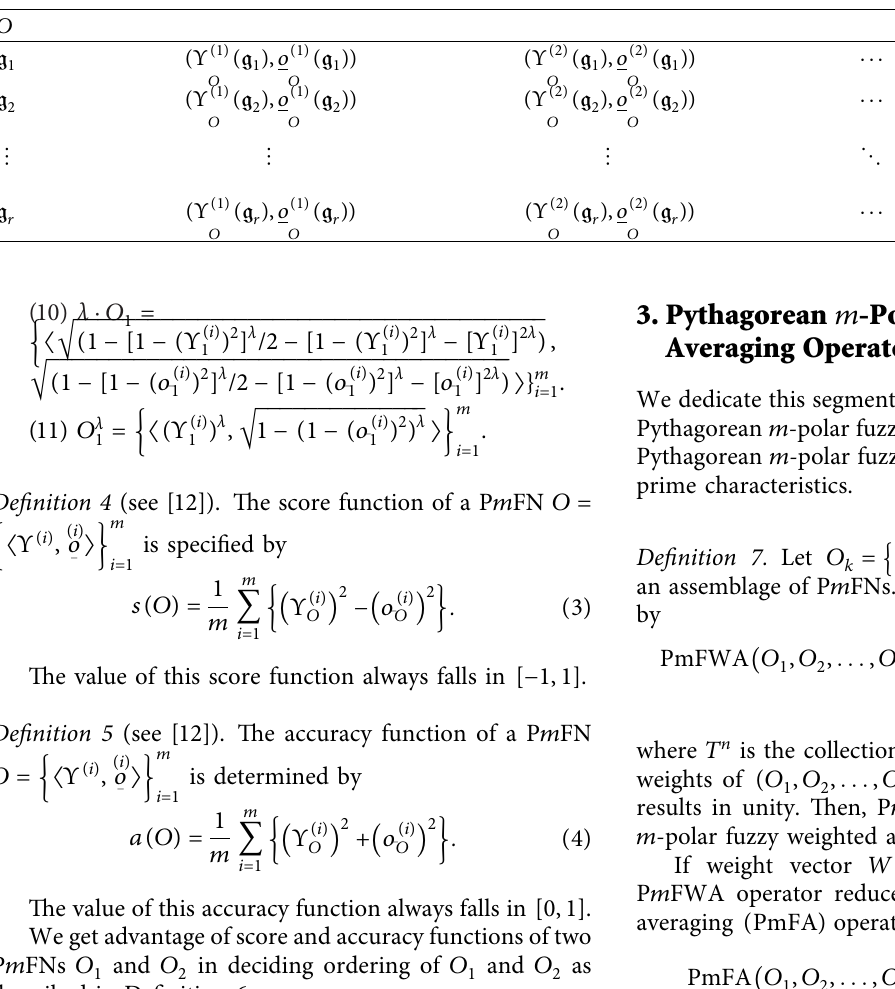
Table 1: Tabulatory array of O